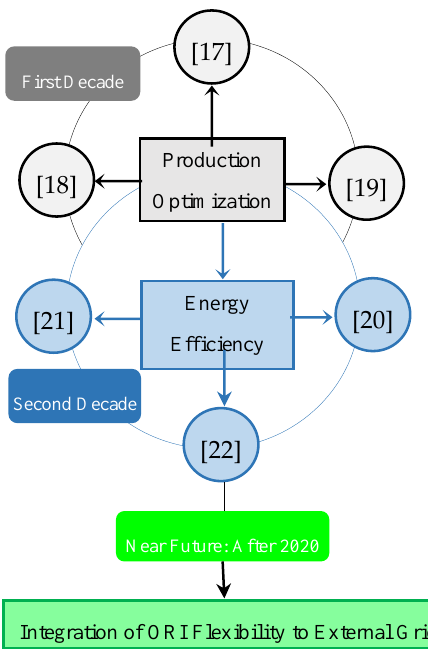
Figure 1. Flow diagram of the literature on the oil refining industries (ORI), with the clear need for future research.